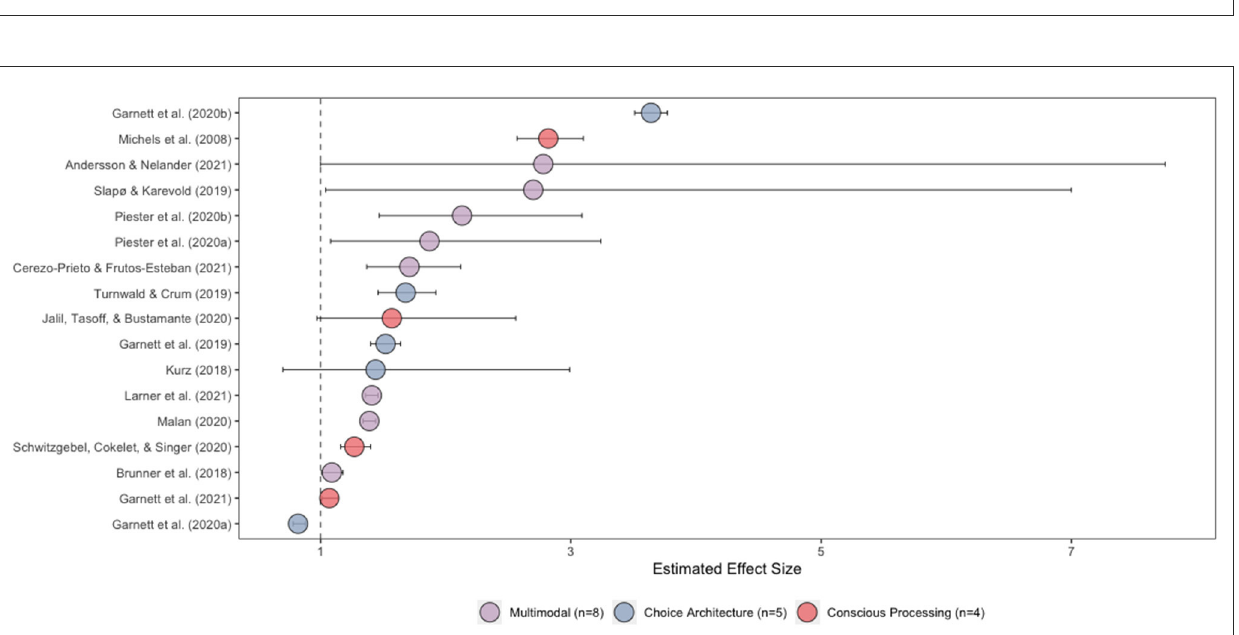
FIGURE5 Violin plot comparing the effect size distributions for each of the three included evaluation methods. The differences in the magnitude of these effect estimates suggest some level of effect size heterogeneity across the three included methods of evaluation, with observational methods yielding smaller and more precise measurements of dietary